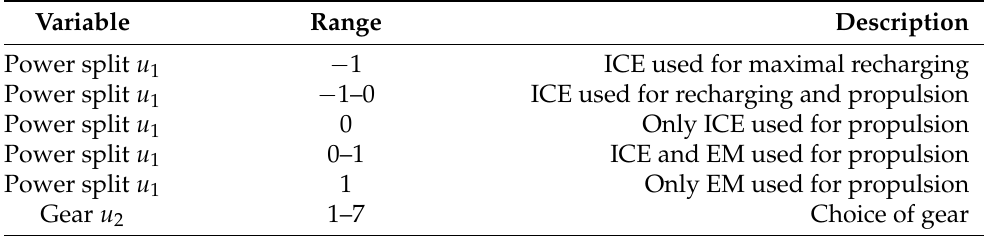
Figure 2. Speed and acceleration data of the worldwide harmonized light vehicle test cycle (WLTC) of Class 3. Table 2. Optimization